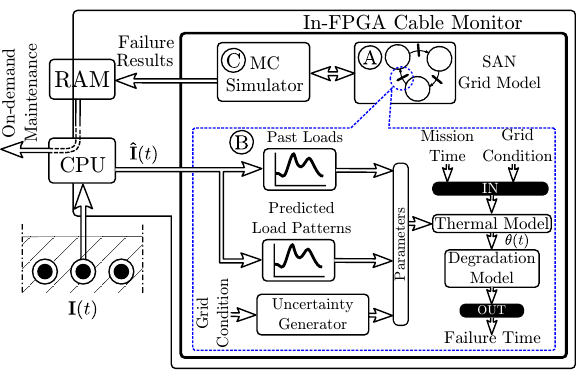
Figure 1. FPGA-based cable reliability monitor architecture.